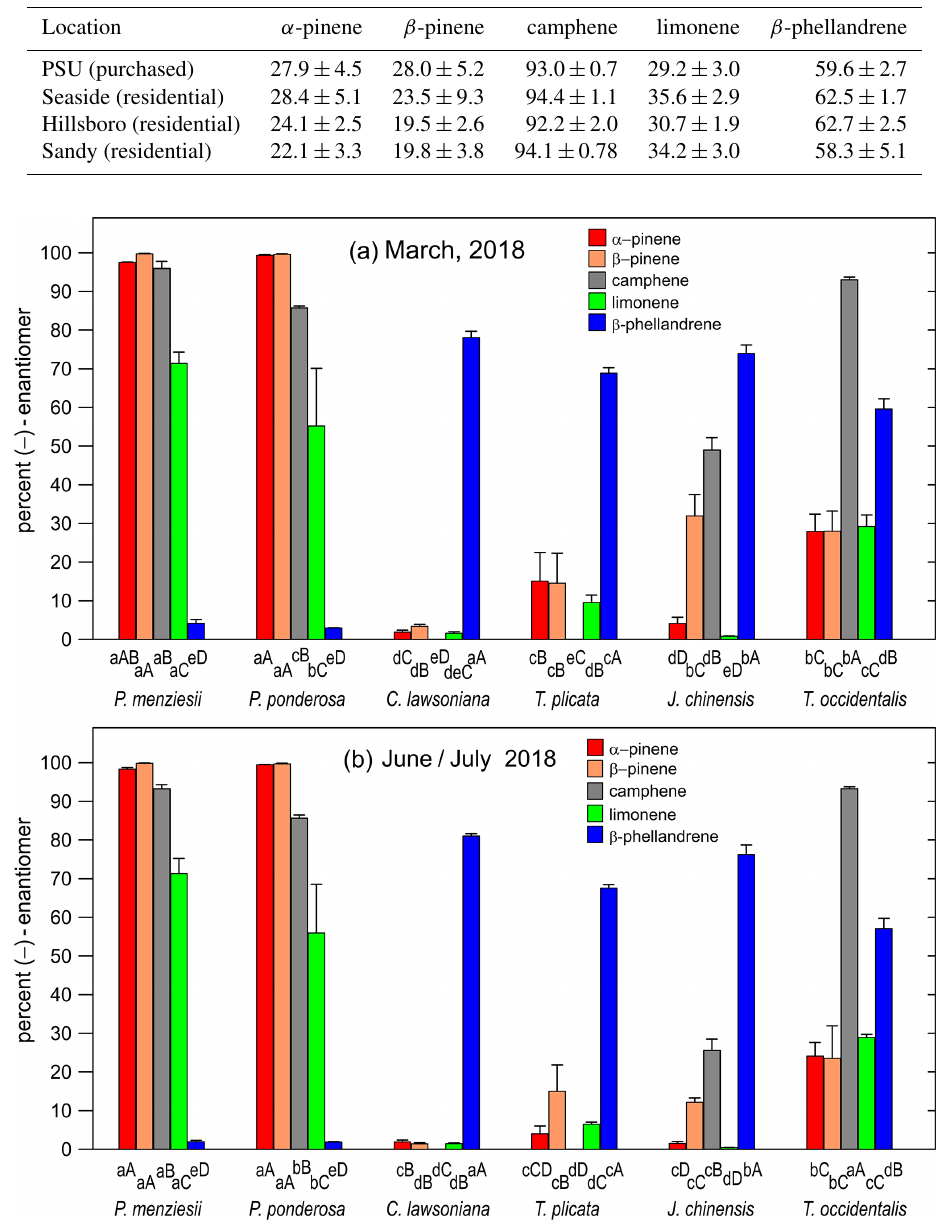
Table 5. Percent ( − )-enantiomer values ± 1 standard deviation (SD) for five chiral monoterpenes in Thuja occidentalis in four nursery- purchased plants located at PSU and sampled once each ( N = 4) in March 2018, as well as in residentially planted samples found in a field trip to three suburban areas in Oregon (Seaside, N = 7 plants sampled once each; Hillsboro, N = 6 plants sampled once each; Sandy, N = 7 plants sample once each; data are plotted in Fig. 5).